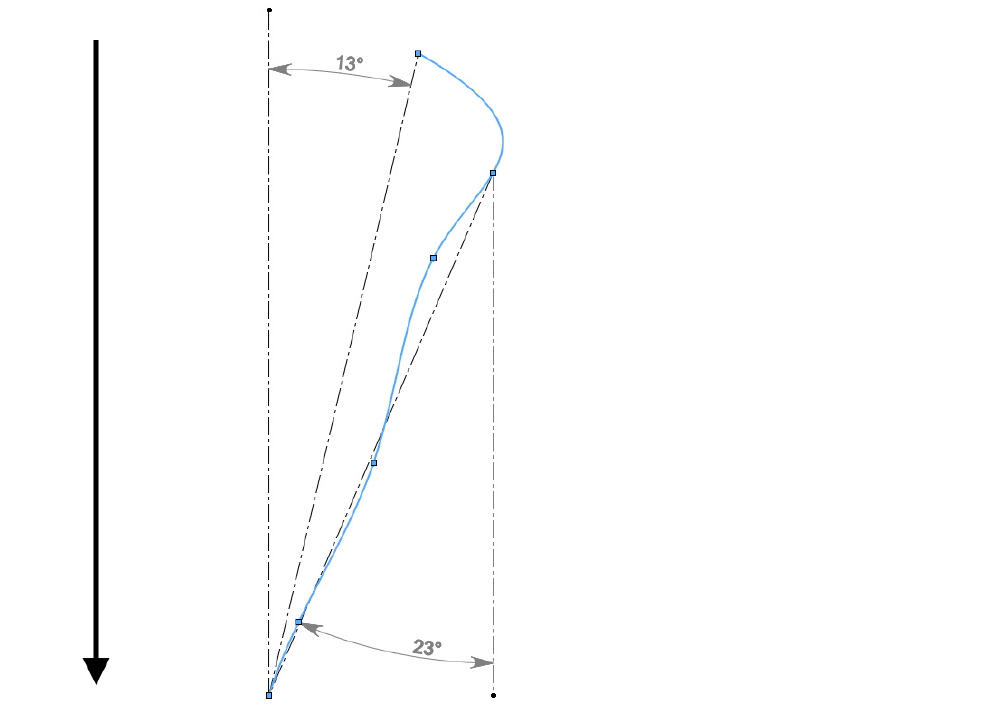
identified with Figure 11. Estimation of the angle of grain orientation with respect to rolling axis (rolling direction is identified with arrow).